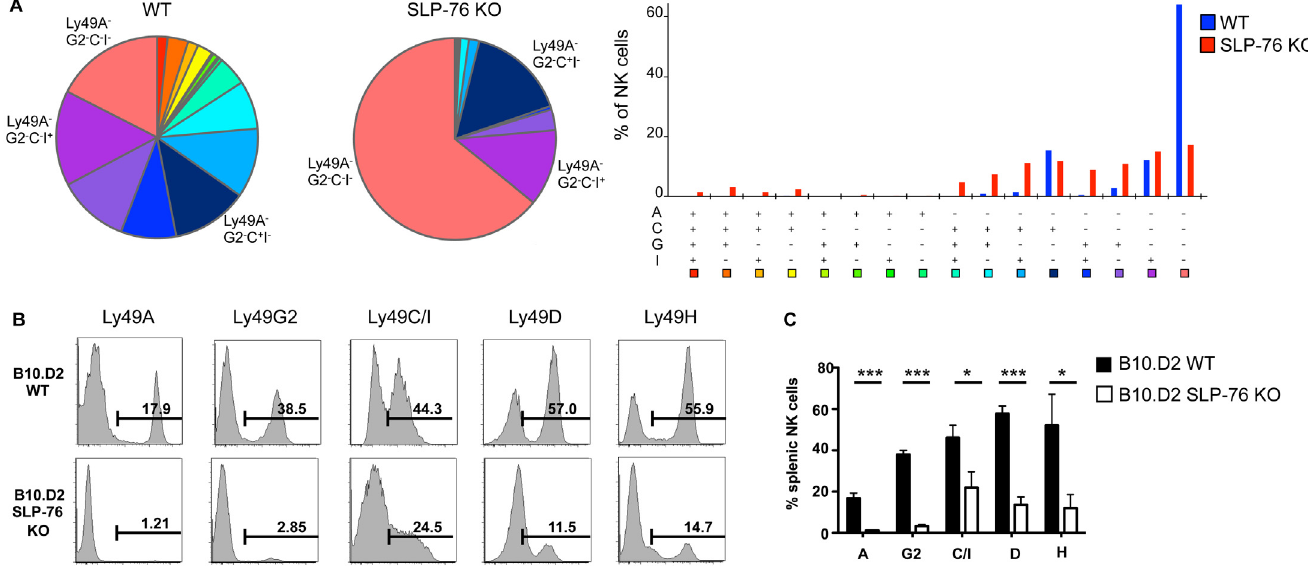
Fig 2. Ly49 receptor expression loss in SLP-76 KO NK cells is independent of MHC I haplotype. (A) The coexpression pattern of inhibitory Ly49 receptor in WT vs SLP-76 KO splenic NK cells was assessed through SPICE analysis. ( B) Representative histograms of Ly49 receptor expression by WT B10.D2 and B10D2.SLP-76 KO splenic NK cells are shown. ( C) The proportion of Ly49 receptor-expressing NK cells from multiple WT B10.D2 (black bars) and B10D2.SLP-76 KO (white bars) mice is represented as mean percent positive ± SEM of n = 3 mice/group. * p < 0.05, *** p < 0.001 by student ’ s t test. See S1 Data for raw